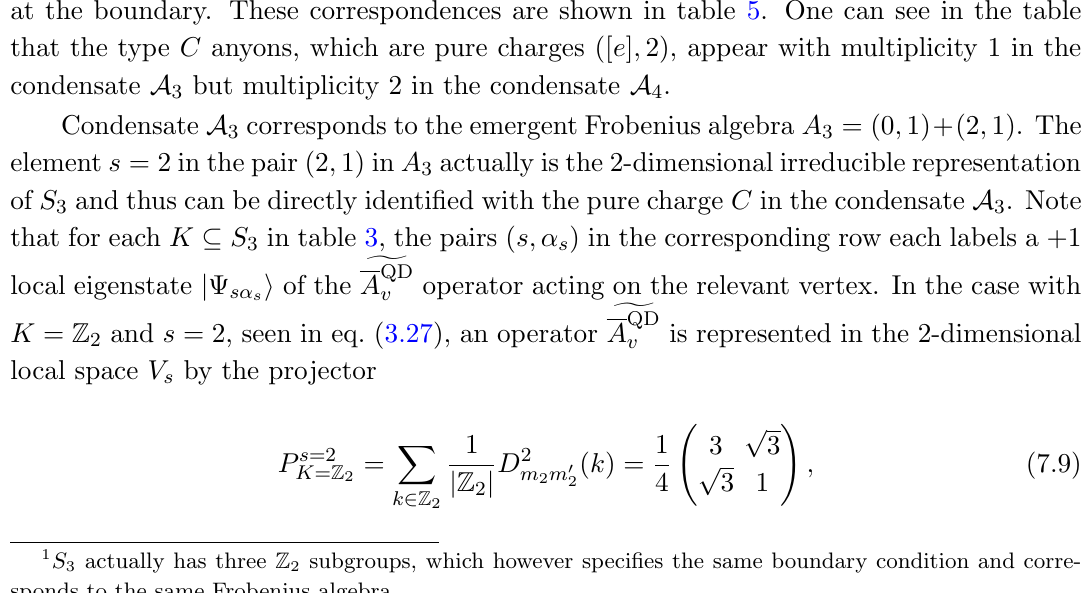
Table 5 . Correspondence between (column 1) anyon condensates of the D ( S 3 ) model, emergent Frobenius algebras (column 2), and subgroups of S 3 (column